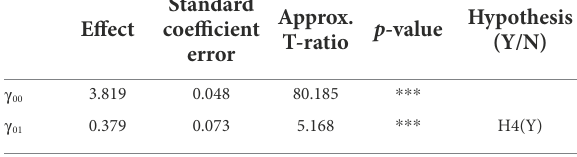
TABLE 3 Results of random coefficients regression model.